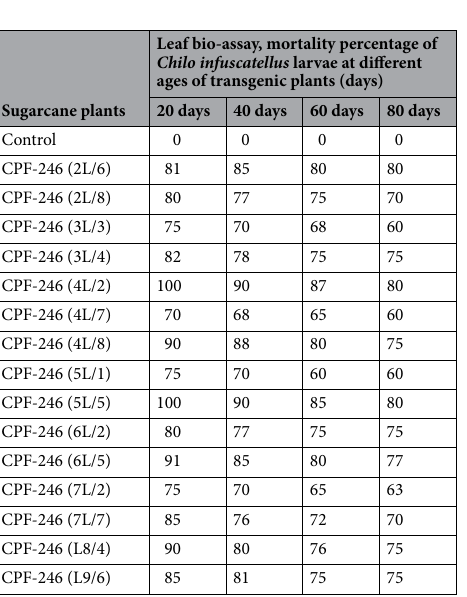
Figure 11. Graphical presentation of morality percentages of Chilo infuscatellus against putative transgenic sugarcane plants at the plant age of 20, 40, 60 and 80 days in V 0 -generation.